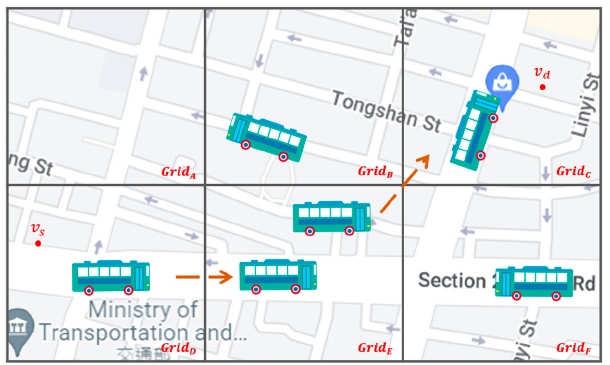
Figure 1. Grid directionality and source-to-destination directionality for intergrid routing of SD-QGrid.